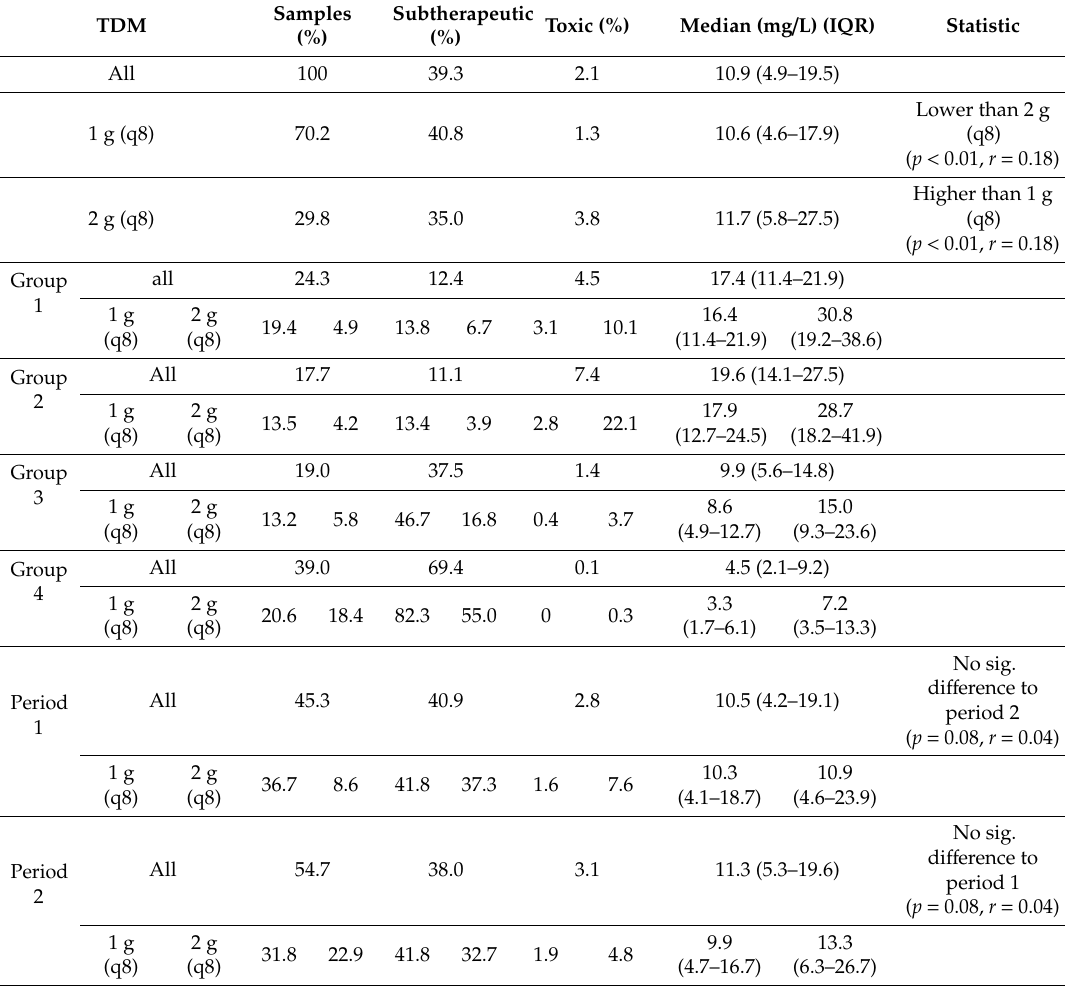
Table 2. Meropenem dosing, meropenem concentration based on renal function, and statistical di ff erences in di ff erent